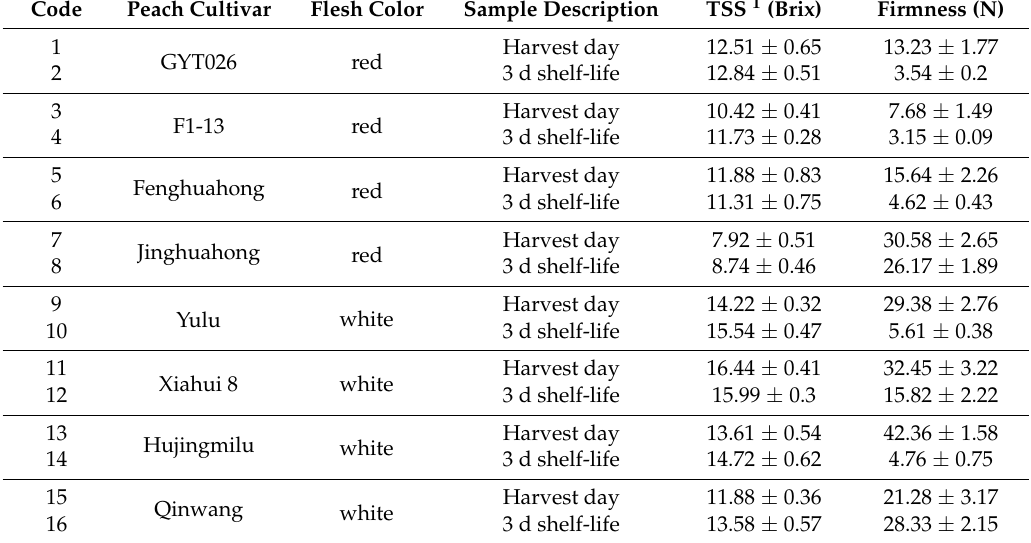
Table 1. Peach fruit samples used in the present